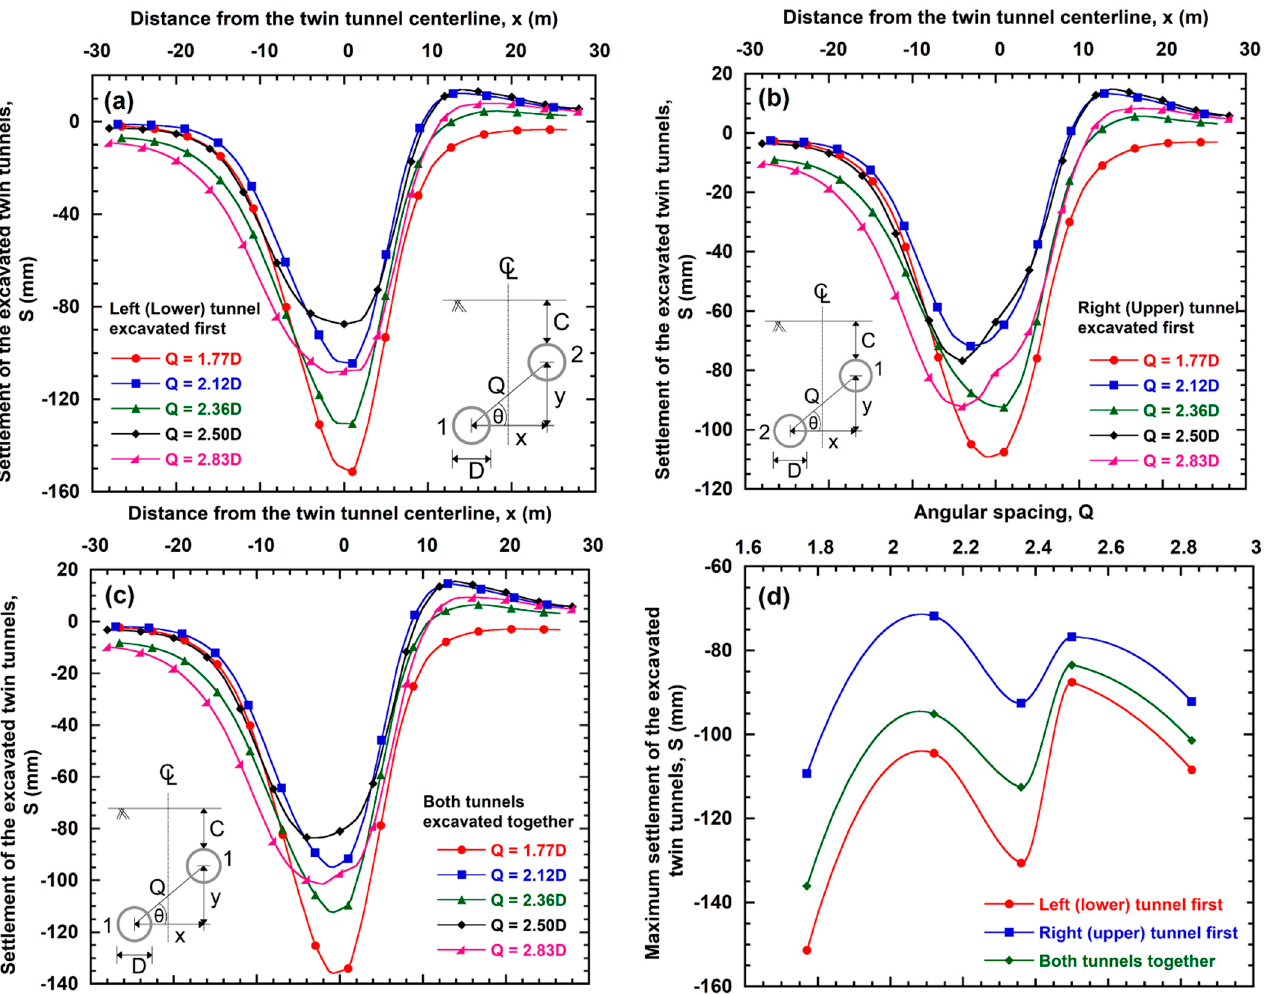
Figure 12. Effect of angular spacing on ( a – c ) combined surface settlement caused by the excavation of offset arrangement twin tunnels and ( d ) maximum total surface settlement of the twin tunnels.